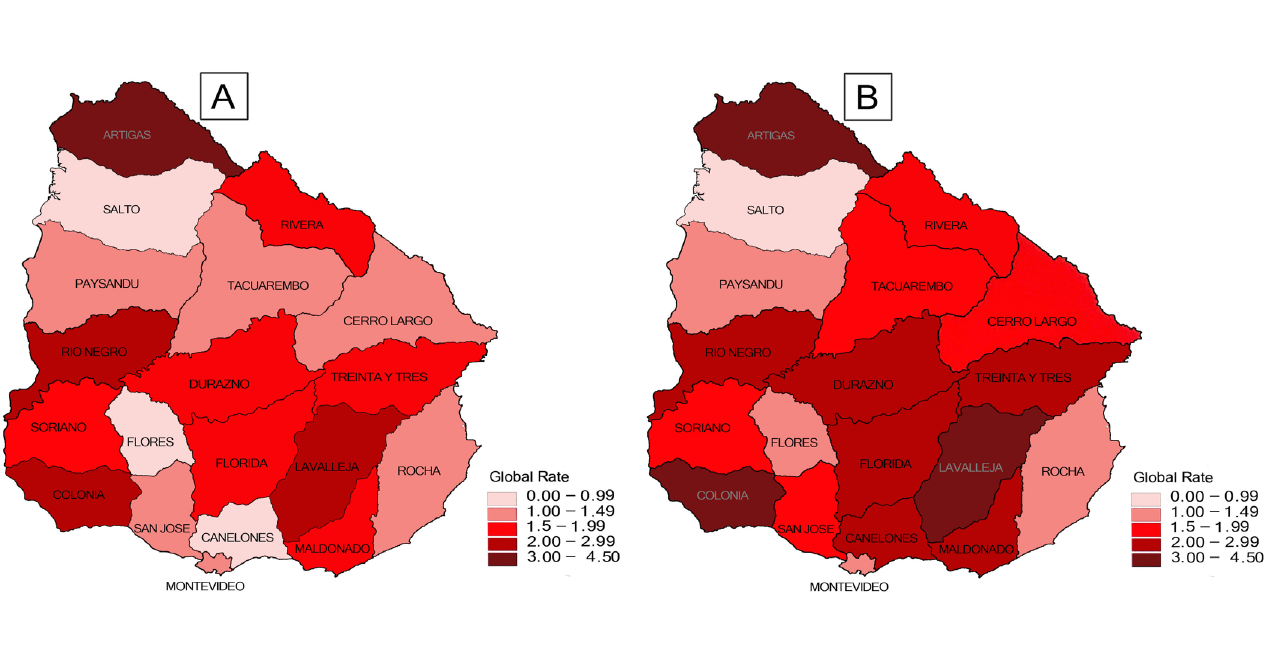
(*) Included Hospitals from the Administration of State Health Services (ASSE); Police, Military and Clinical Hospital. Cases without information about the place of delivery were excluded from the